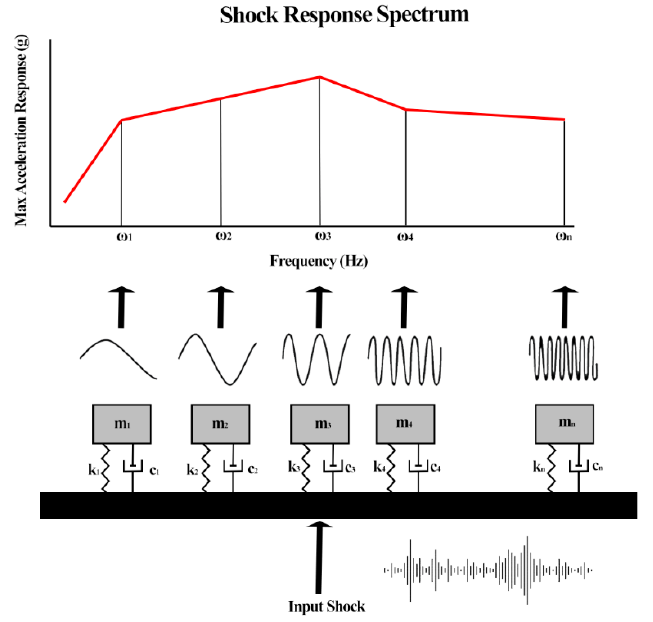
Figure 5. Shock response spectrum.